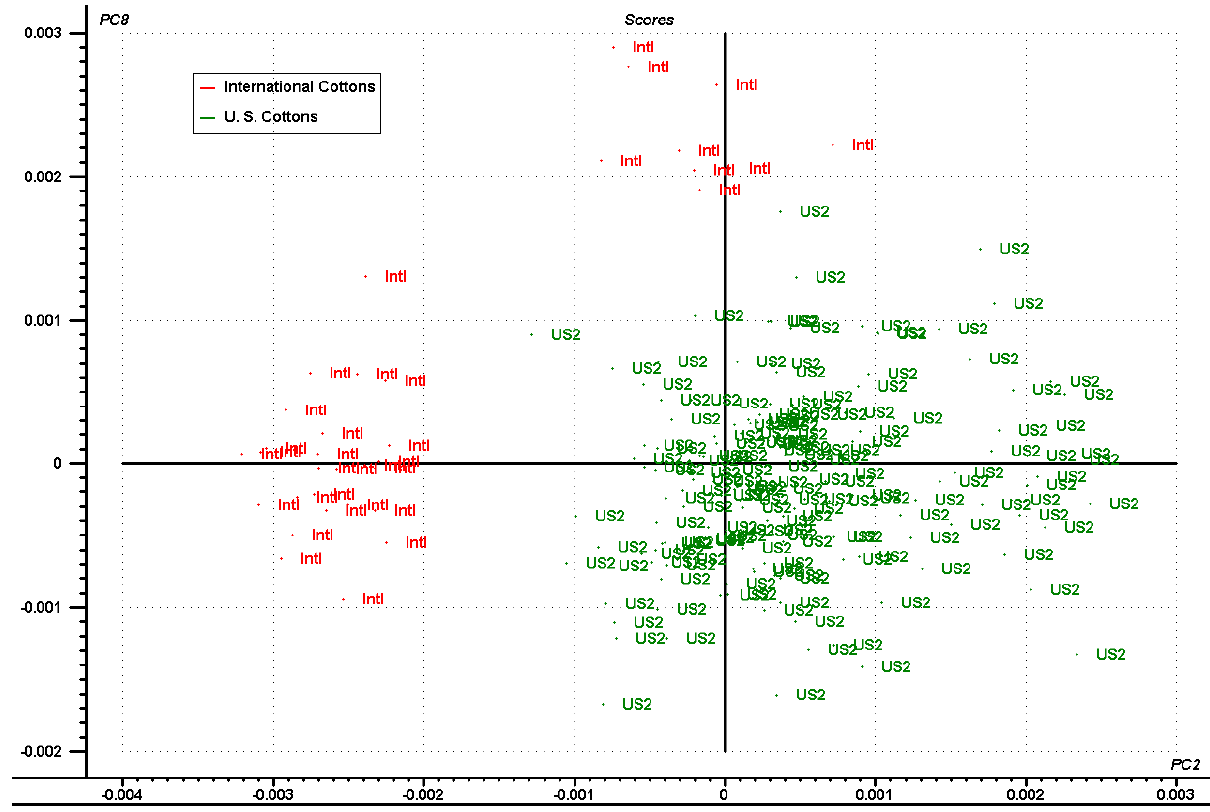
Figure 3. PCA score plot of international (Intl) and U.S. (US2) cottons separated